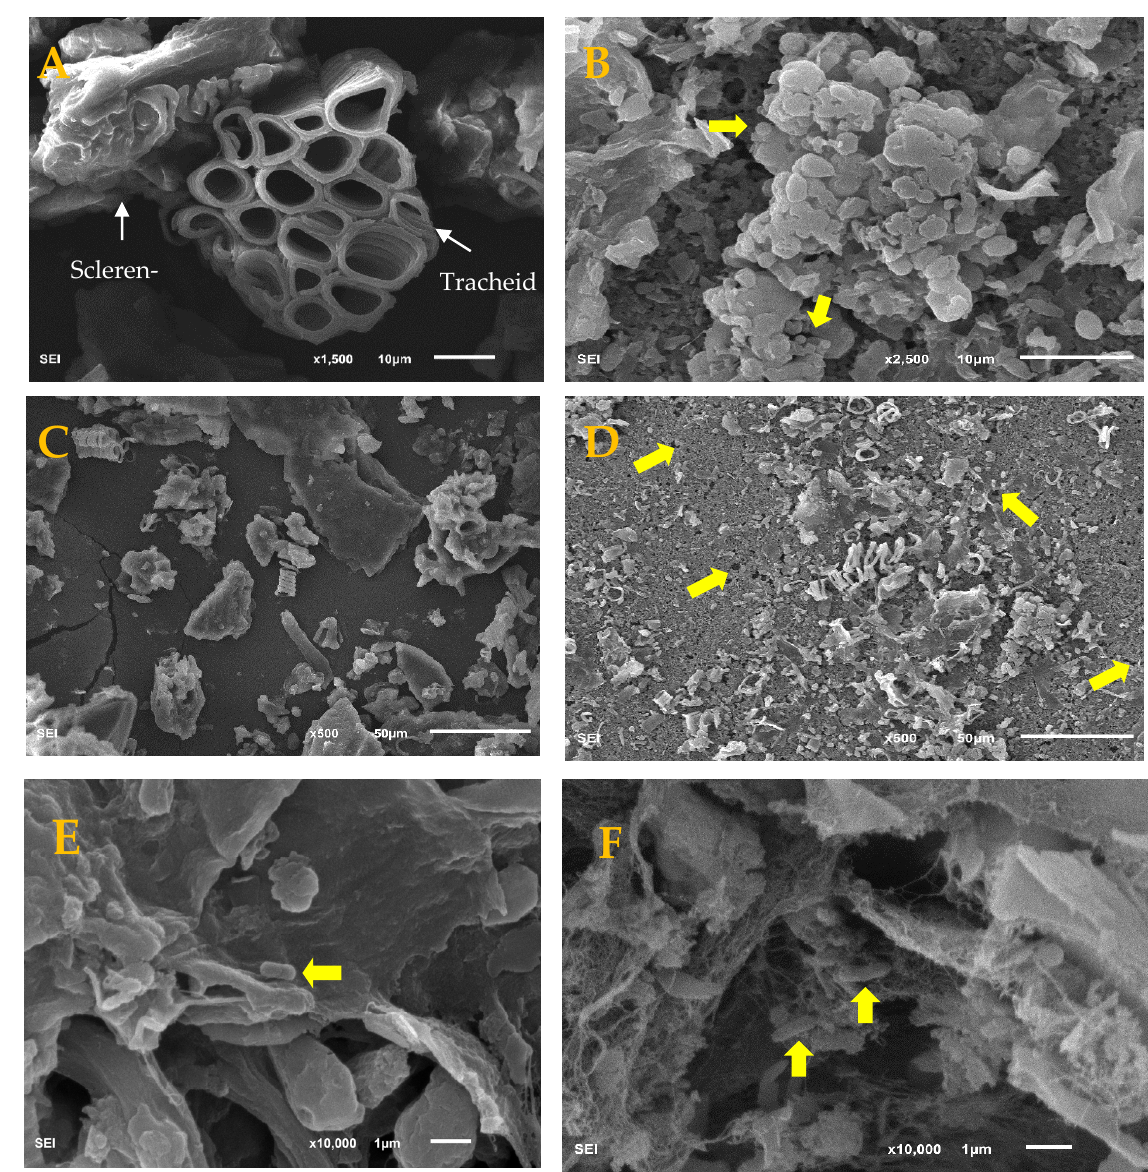
Figure 1. SEM micrographs of CBS powder: ( A – C ) untreated, ( D ) just after hydrolysis, and ( E , F ) hy- drolyzed after 48 h of fermentation (non-centrifuged medium). Magnification indicated in each